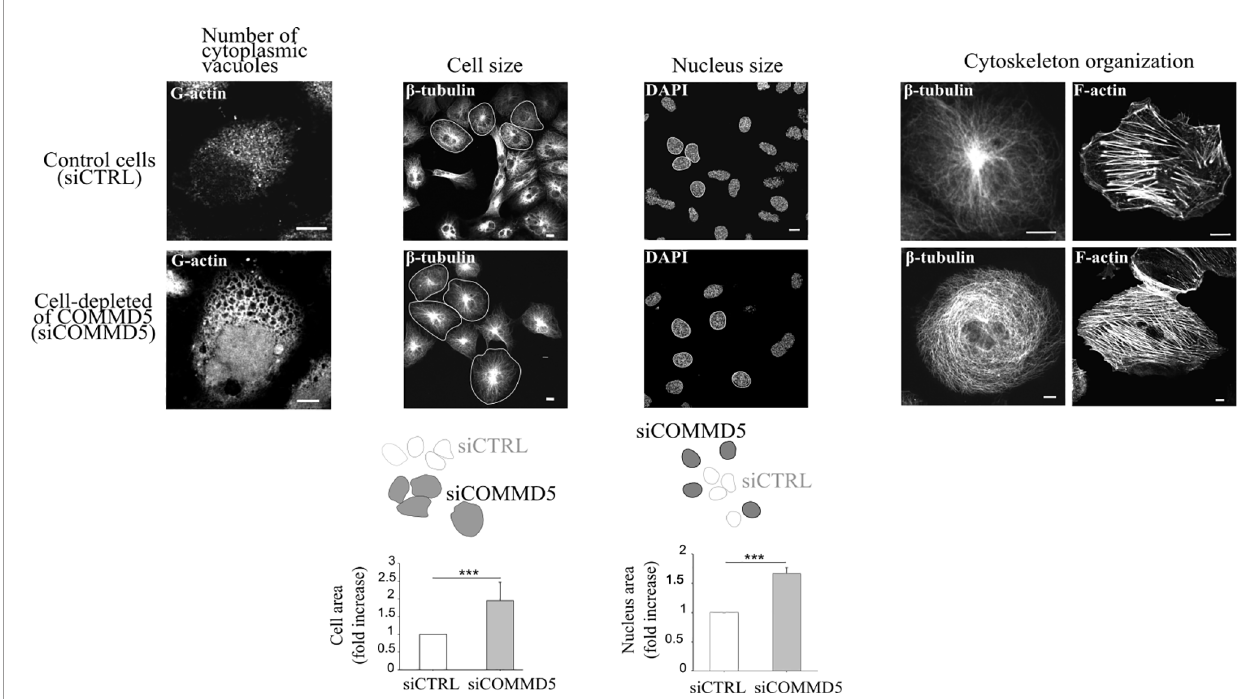
FIGURE 6 | Loss of COMMD5 leads to cellular morphological changes including cytoskeleton organization. HK-2 cells were transfected with COMMD5 speci fi c siRNA (siCOMMD5) or control siRNA (siCTRL), fi xed, and labeled with fl uorescein-deoxyribonuclease 1 (for G-actin), b -tubulin, phalloidin (for F-actin) or DAPI (for nuclei staining). Cell size or nucleus area in cells transfected with siCTRL or siCOMMD5 were processed and analyzed using FIJI software (values are means, error bars indicate SD, n = 3). Student ’ s t test, ***p < 0.001, signi fi cant differences compared with